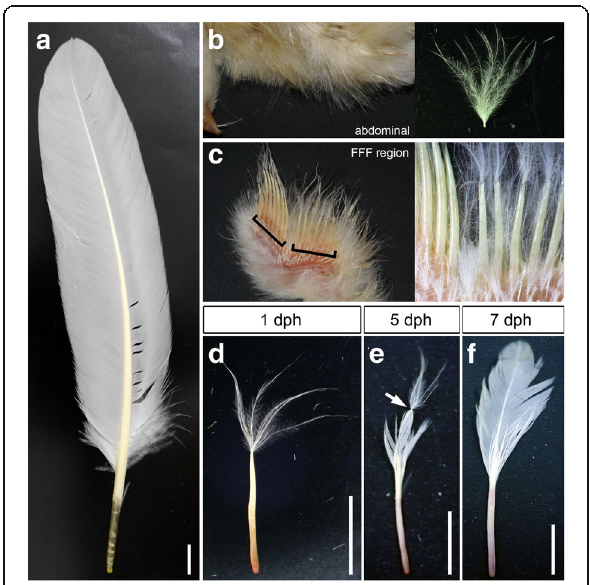
Fig. 1 Development of remex-type flight feathers after hatching. a A flight feather in the adult chicken. b Natal down feather in the abdominal tract at 1 dph. An uprooted abdominal natal down feather is shown on the right side. c Ventral view of the FFF region at 1 dph. Some rows of feathers in the ventral surface of the wing are trimmed. Staples indicate the FFF region. An magnified photograph is shown on the right side. d – f A feather uprooted from the FFF region at 1 dph ( d ), 5 dph ( e ), and 7 dph ( f ). Note that in e , a distal downy part is connected with a proximal bilateral part that starts opening (white arrow). Scale bars: 1